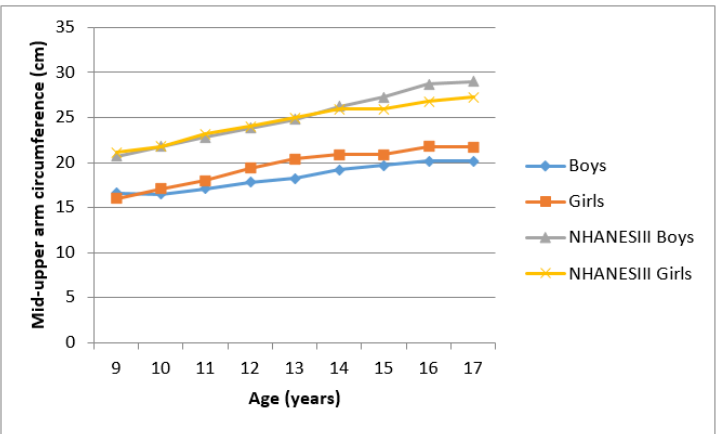
Figure 1. Mean mid-upper arm circumference of Ellisras children compared to the NHANES III reference population aged 9–17 years.